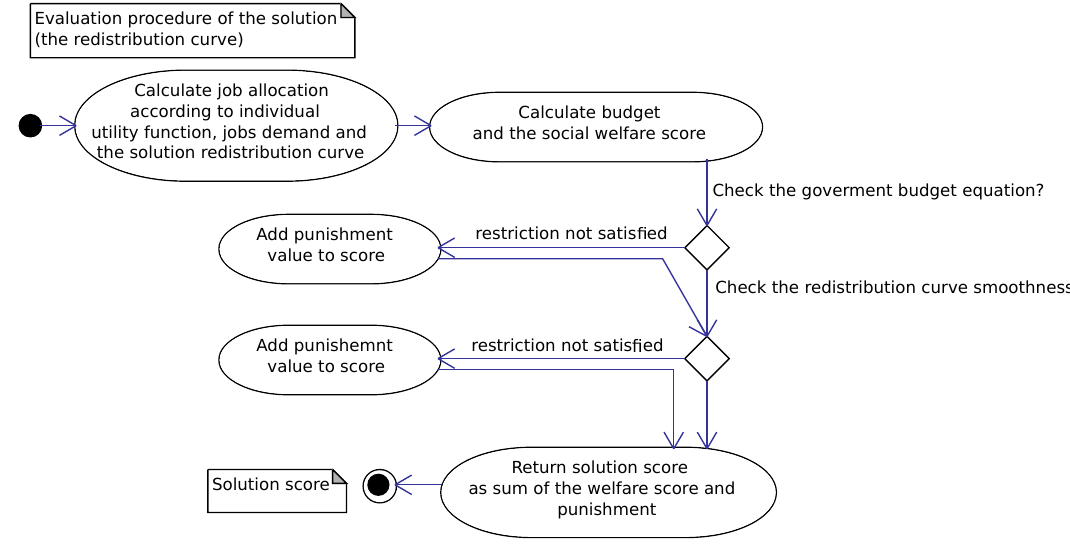
Figure 9. The solution evaluation